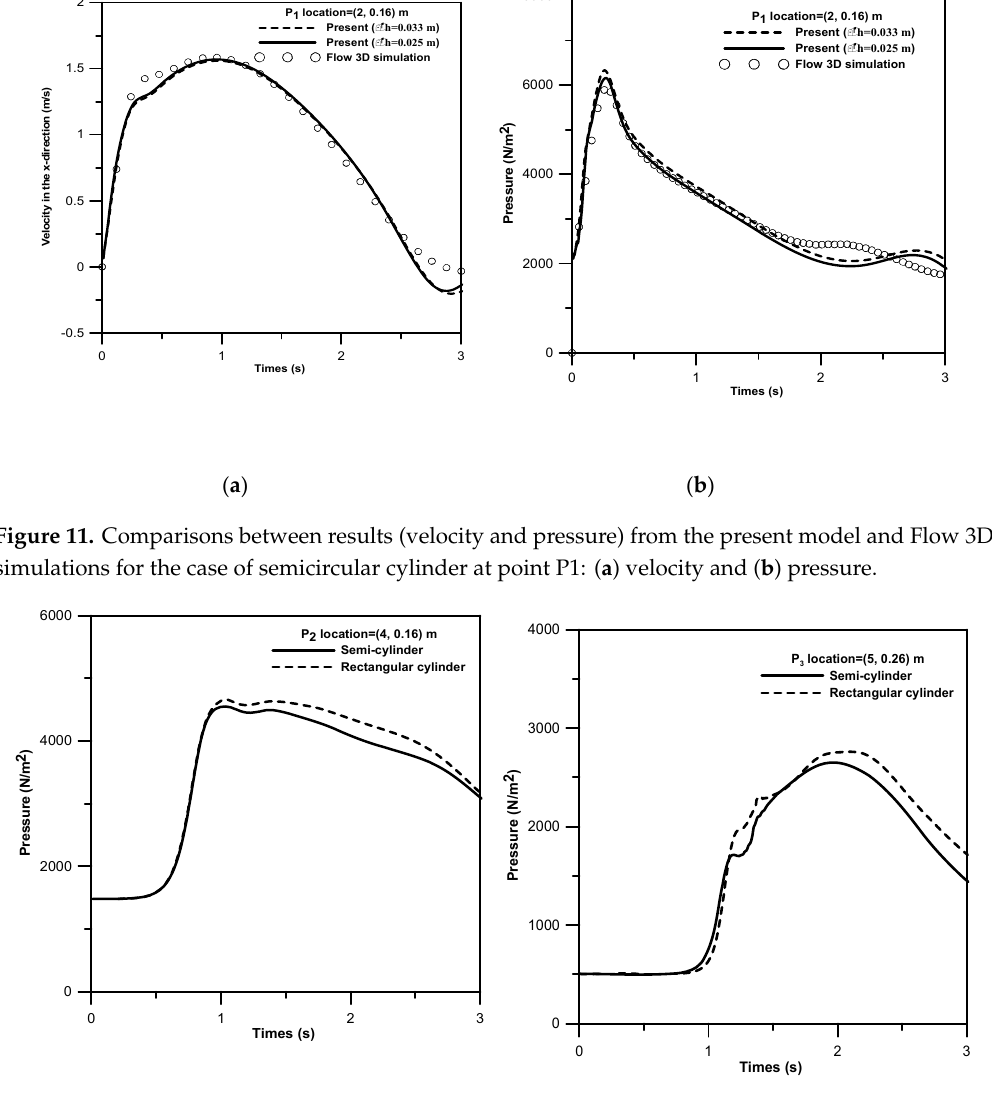
Figure 12. Comparisons of pressure variations for a dam ‐ break flow over a semicircular and a rectangular cylinder at fixed points of ( a ) P2 at (4 m, 0.16 m) and ( b ) P3 at (5 m, 0.26 m).